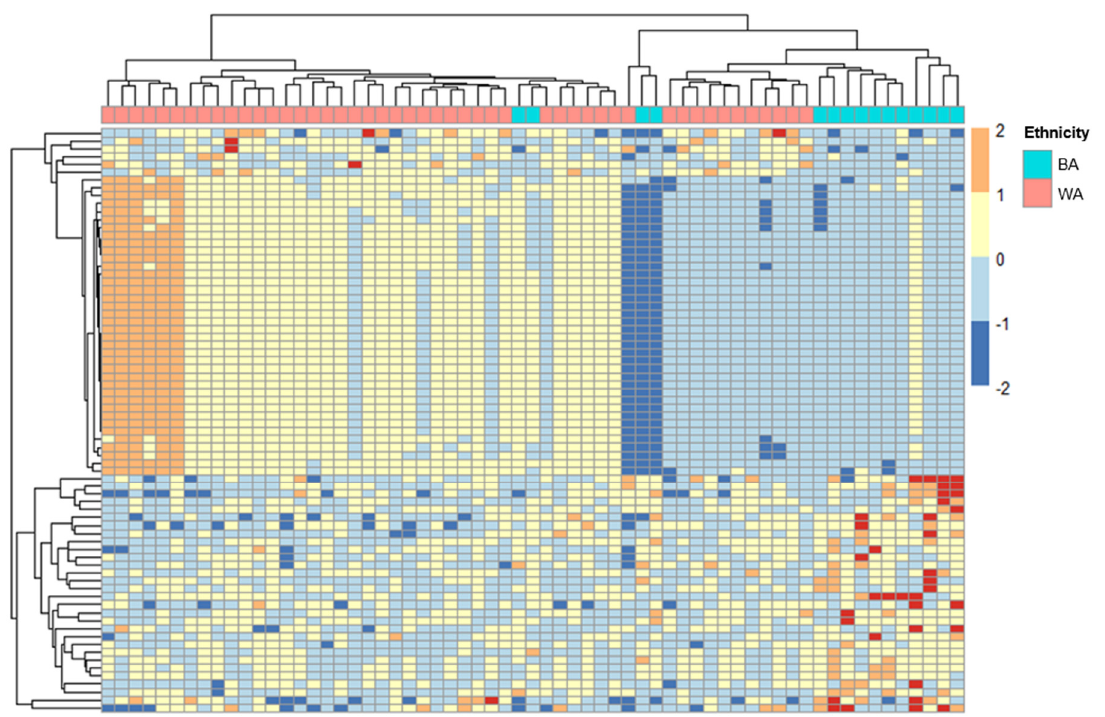
Figure 1. Transcriptome analysis of ERVs in Black American and White American cervical cancer patients. ERVs from 63 cervical cancer patients were mapped to the HERVd database. Differential expression analysis and hierarchical clustering analysis (Euclidean) were performed in DeSeq2 to organize the tumor samples based on their ERV transcription profiles and the ancestry of the cervical cancer patients. The heat map was generated using the normalized expression values for 74 sig- nificantly differentially expressed ERVs in BA vs. WA. The plot above depicts the most significant differentially expressed ERVs ( p adj < 0.1) in BA (n = 15) vs. WA (n = 48) that were differentially expressed among samples of different ancestries (a complete list of differentially expressed ERVs can be found in Supplementary Table S1). Each column represents one sample, and each row represents a single ERV. ERV expression level is indicated by color intensity ( − 2.0 to 2.0) on a log scale; red indicates ERVs with higher expression, and blue indicates those with lower expression. ERV expres- sion was normalized to the mean of all samples. In the dendrogram on the top, the ancestral origin of each patient is indicated by color. Red indicates patients of predominantly European/Middle Eastern (n = 48) geographical ancestry, while blue represents patients of African ancestry (n = 15). BA = Black American; WA = White American.